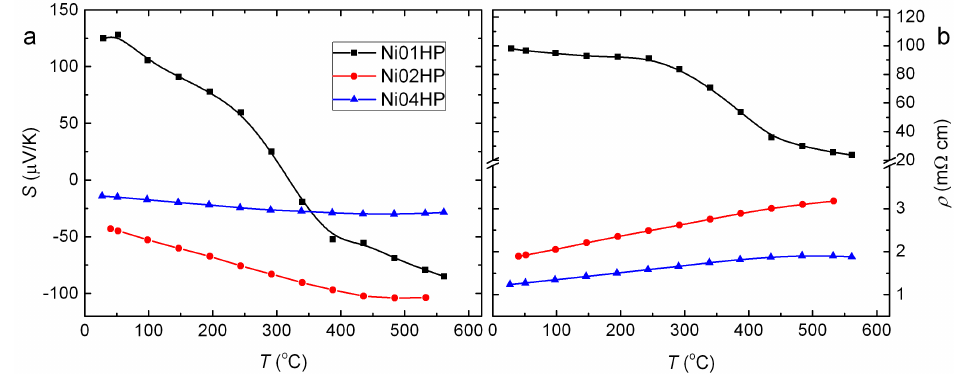
Figure 5. Temperature dependence of Seebeck coefficient ( a ) and electrical resistivity ( b ) for the series of hot pressed samples.